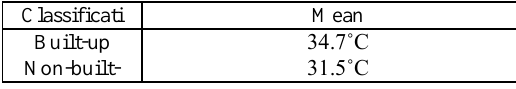
Table 2. The mean LST of built-up and non-built-up